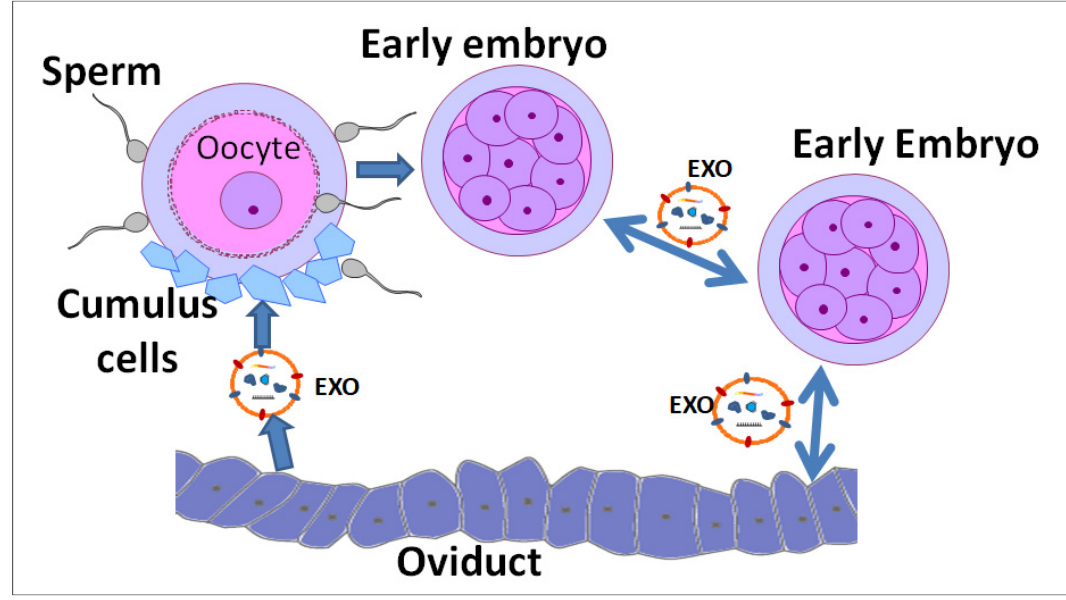
Figure 1. The proposed interaction between the oviduct, cumulus-oocyte complex, sperms, and embryos through the exosomes (EXO). Exosomes contain bioactive cargo molecules such as mRNA, miRNAs, and proteins; they are transferred from secreting cells and regulate the physiological processes in the target cells.